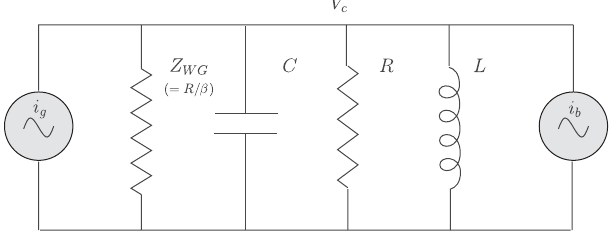
FIG. 2. Equivalent circuit model for a beam-loaded cavity as seen from the internal cavity circuit. The cavity is excited by the and the beam current i generator current i g b